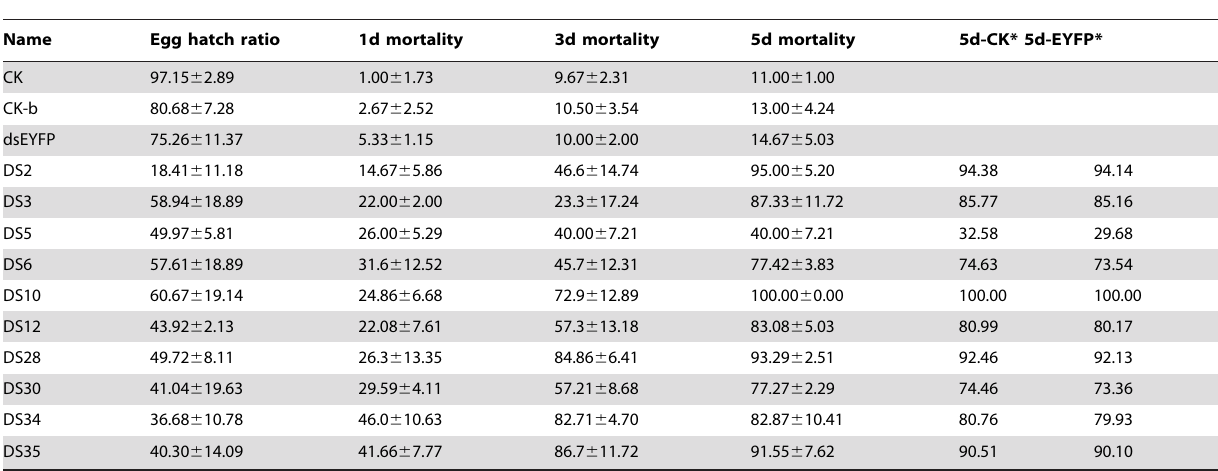
Table 6. The eggs hatch ratio and larval mortality (%) after spraying 50 ng/ m l